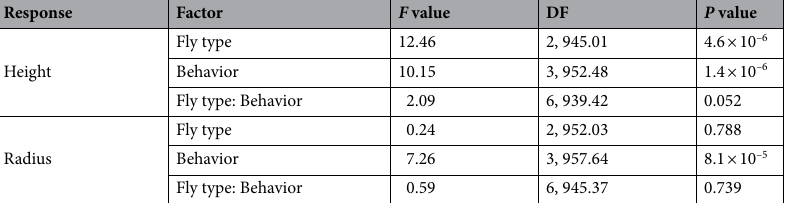
Table 3. Differences in height and radius with respect to fly type (fertile mass-reared, sterile mass-reared, and wild), behavior (resting, grooming, walking, and feeding), and the interaction between these two variables. Significance of these fixed factors was assessed using linear mixed modeling, with both models including day as a random factor. F-statistics were calculated using type III ANOVA with Satterthwaite’s method.